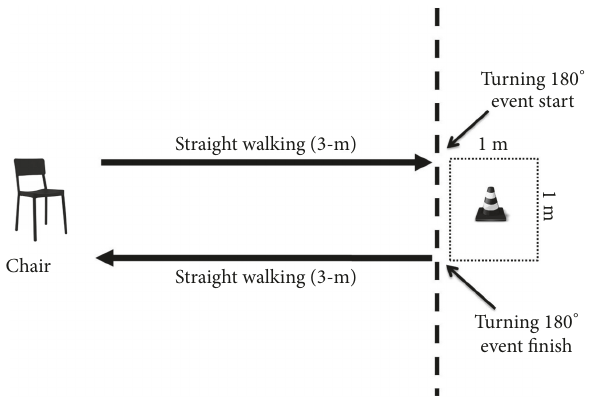
Figure 1: Layout for the modified timed up and go